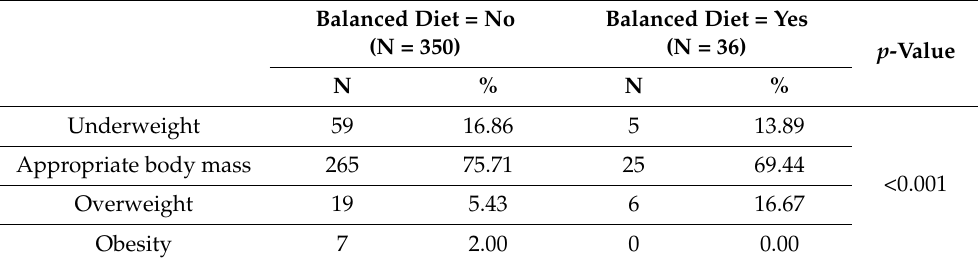
Table 7. The relationship between a well-balanced diet and body